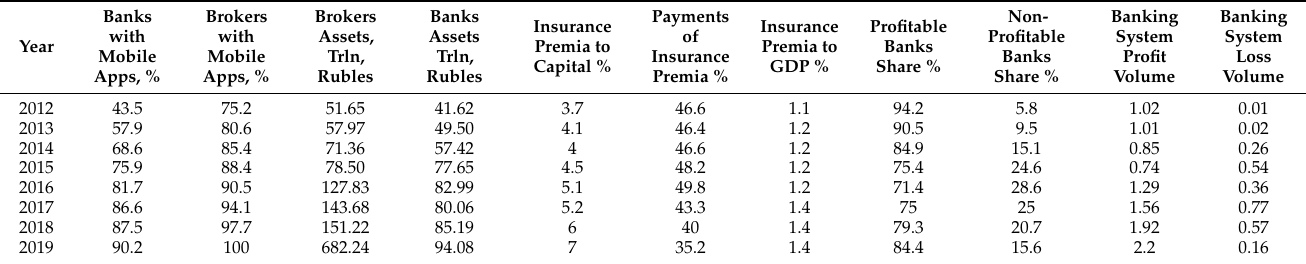
Table 1. Attributes of the Russian finance sector from 2012 to